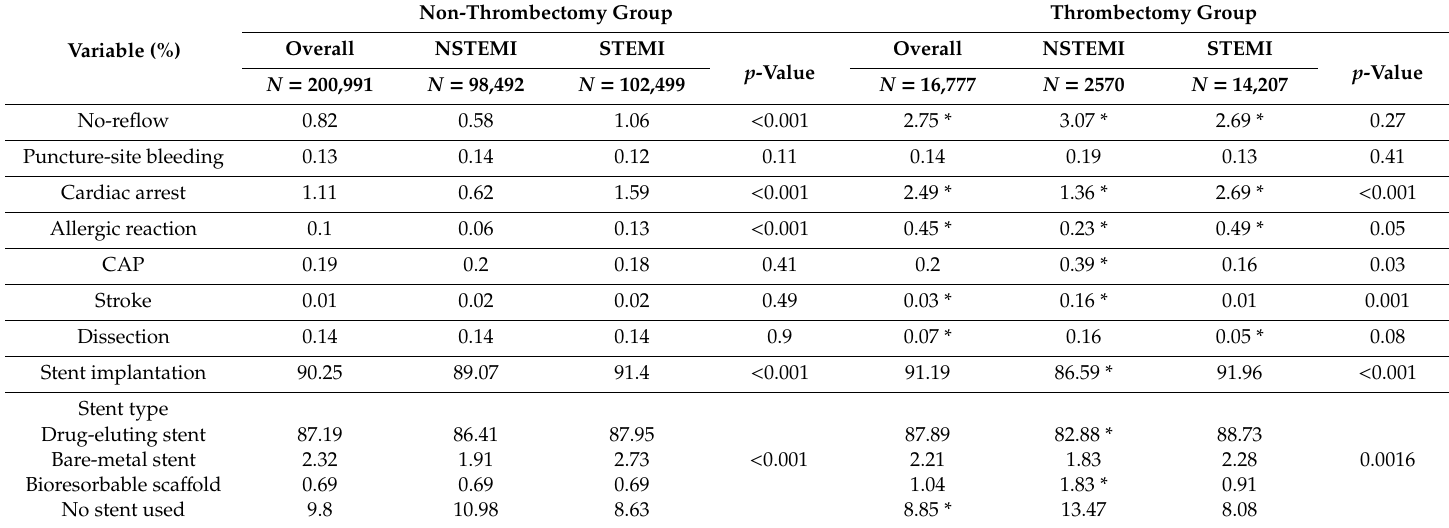
Table 3. Procedure-related complications according to type of myocardial infarction (MI)—non- thrombectomy and thrombectomy groups.